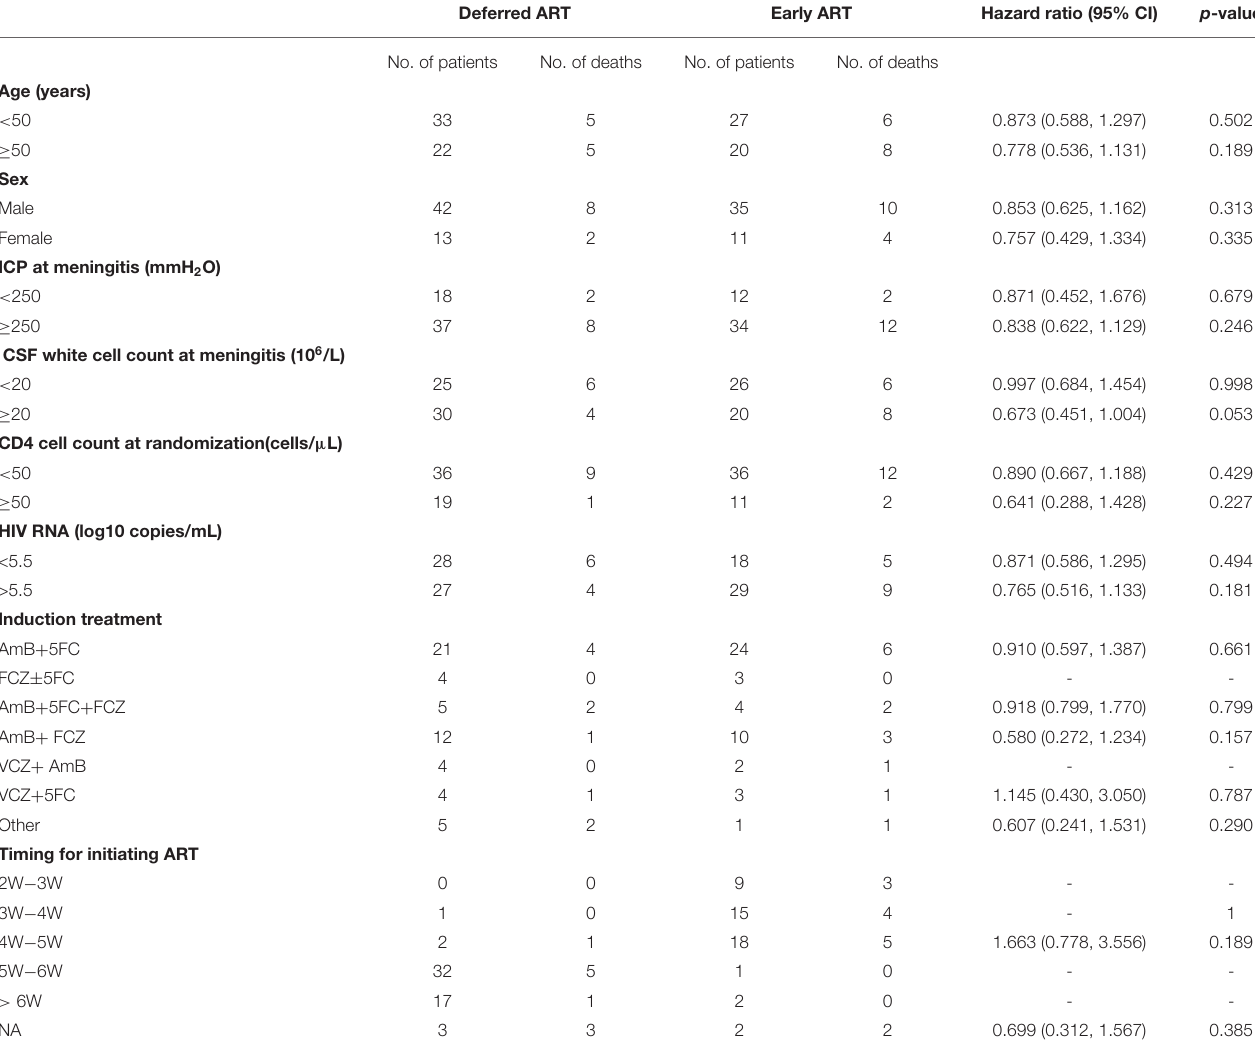
TABLE 3 | Subgroup analysis of 24-week mortality in the Intention-to-Treat